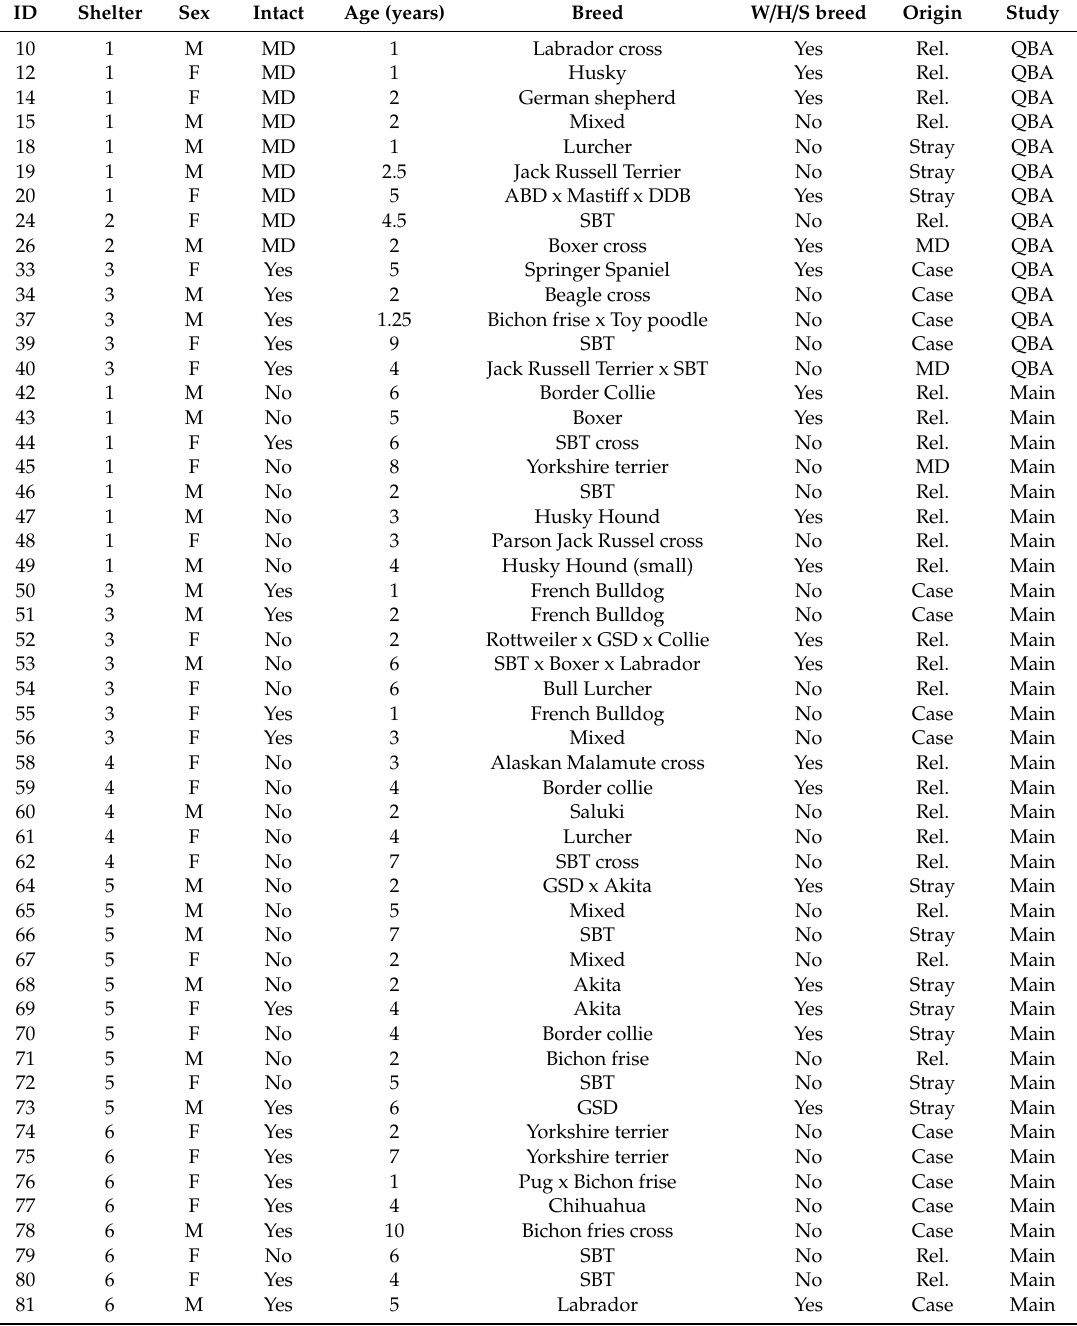
Table 1. Individual characteristics of the 14 pilot study dogs included in the qualitative behaviour analysis (QBA) and the 43 dogs from the main study for which complete data sets were